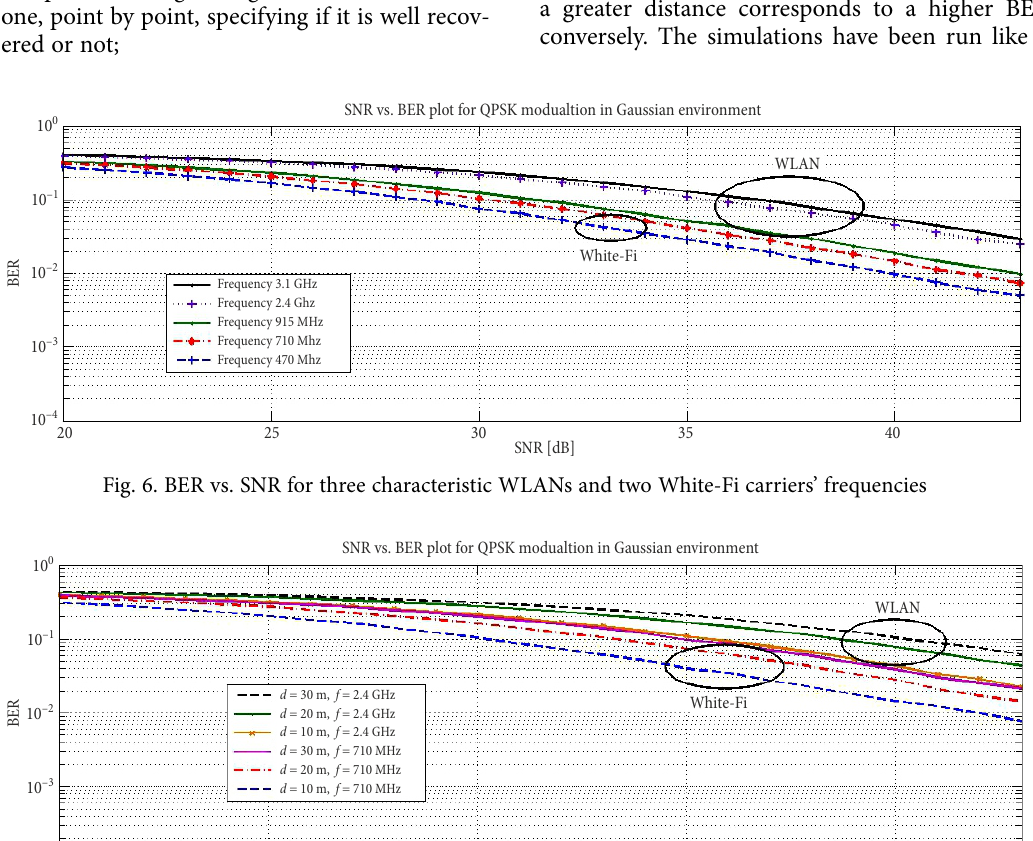
Fig. 7. BER vs. SNR for three different distances at two characteristic WLAN and White-Fi carriers’